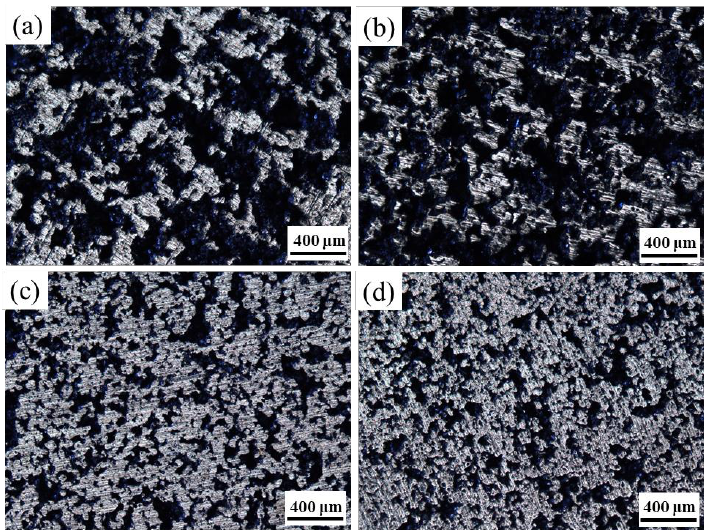
Figure 7. Microstructure of sintered porous NiTi alloys with different solid loading rates: ( a ) 42 vol.%; ( b ) 45 vol.%; ( c ) 48 vol.%; ( d ) 51 vol.%.